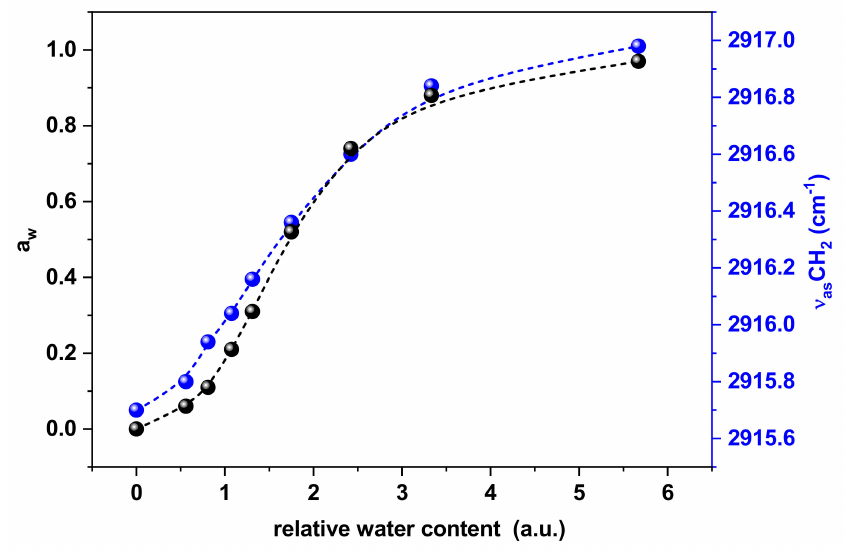
Figure 3. Water activity (black dots) and CH 2 frequency (blue dots) at different water content.